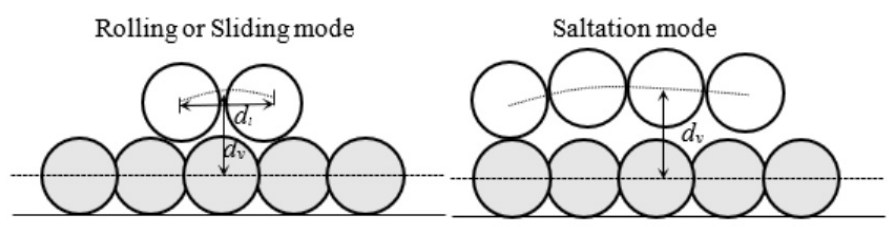
Figure 7. Criteria of distinction between sliding, rolling, and saltation.